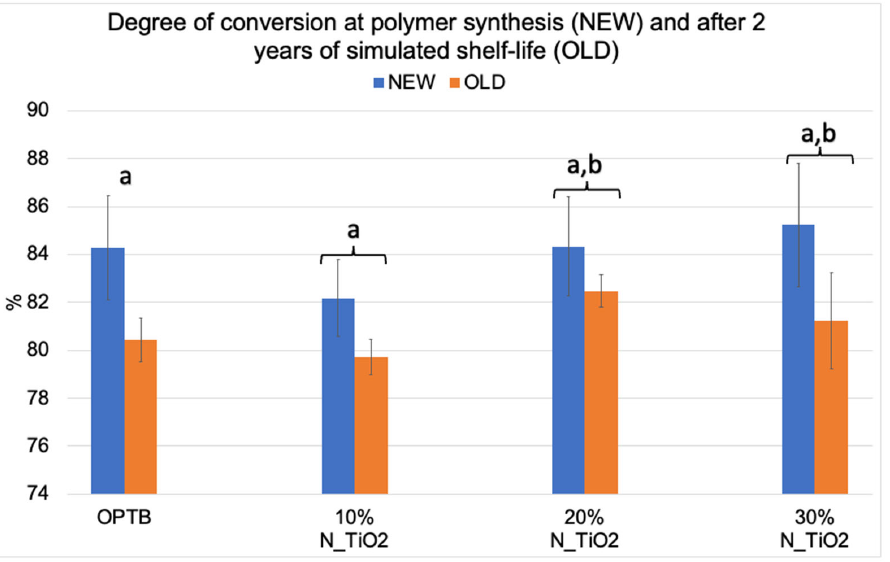
Figure 2. Mean and standard deviation values of degree of conversion (DC) of unaltered (OPTB) and experimental adhesives (OPTB + N_TiO 2 [10%, 20% or 30%, v / v ]). Connecting braces denote no statistical differences ( p > 0.05) between NEW and OLD within each group. Letters above bars illustrate the SNK rankings and denote the presence of significant ( p < 0.05) intergroup differences.